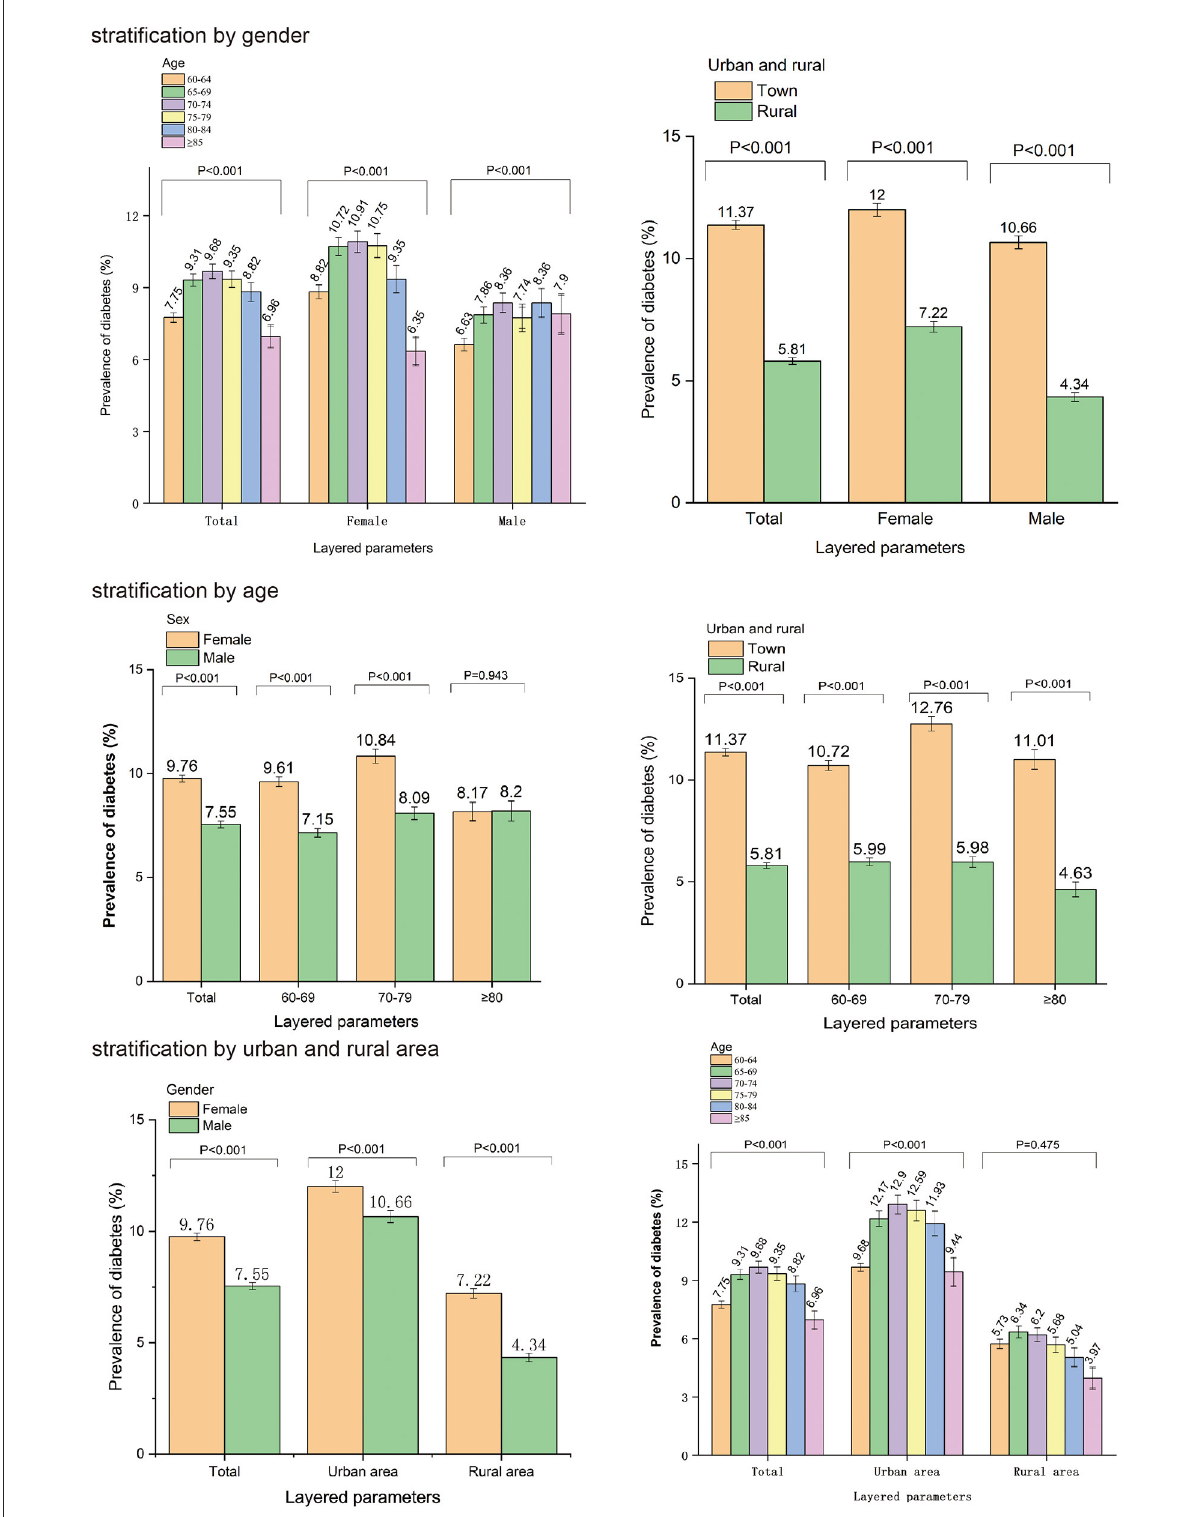
FIGURE5 The relationship between parameters and diabetes was further analyzed by gender, age, and urban and rural residence